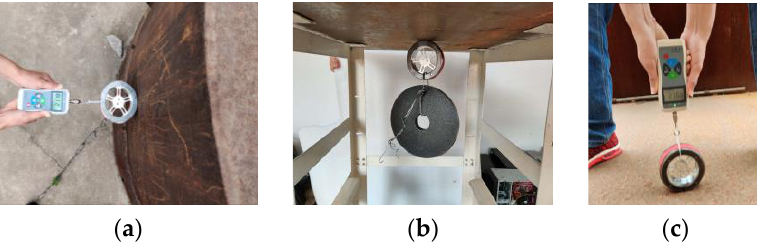
Figure 3. Influence of structural parameters on the magnetic wheel. ( a ) Number of magnets (Num); ( b ) thickness of the yoke (Thk); ( c ) thickness of the yoke hole shoulder (Eys); ( d ) arrangement.